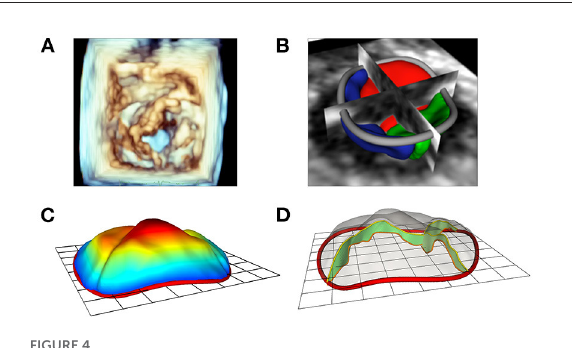
FIGURE4 Modeling of valve leaflets and quantification of annular and leaflet structure. (A) Volume rendering of a tricuspid valve using Phillips Qlab Software; (B) Visualization of a tricuspid valve (right atrial view) segmentation with slice intersections (blue = septal leaflet, red = anterior leaflet, green = posterior leaflet) in SlicerHeart; (C) Color intensity map depicting quantitative degree of billow in a tricuspid valve with 2D annular plane visible in SlicerHeart; (D) Visualization of leaflet coaptation regions with 2D annular plane visible in